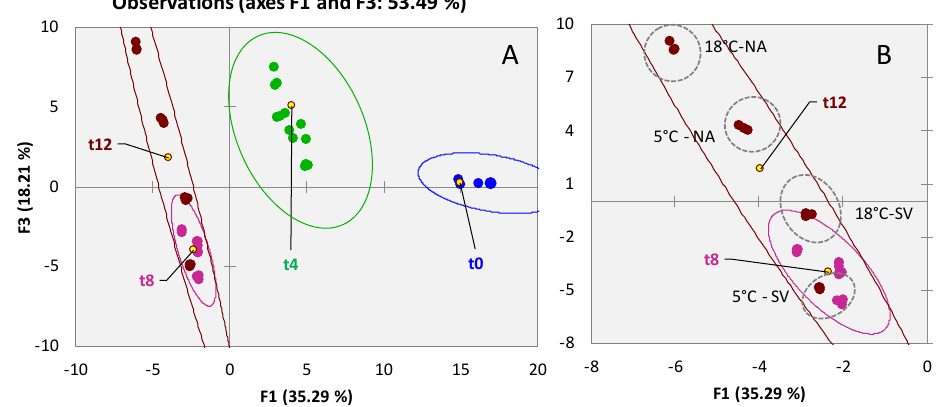
Figure 2. PCA scores plot based on normalized chromatographic areas from 91 targeted compounds across all analyzed almond samples (Figure 1A). Confidence ellipses (95% of confidence) relate to shelf-life (t0-blue; t4-green; t8-purple; t12-garnet color). Insight on t12 samples in (Figure 1B).